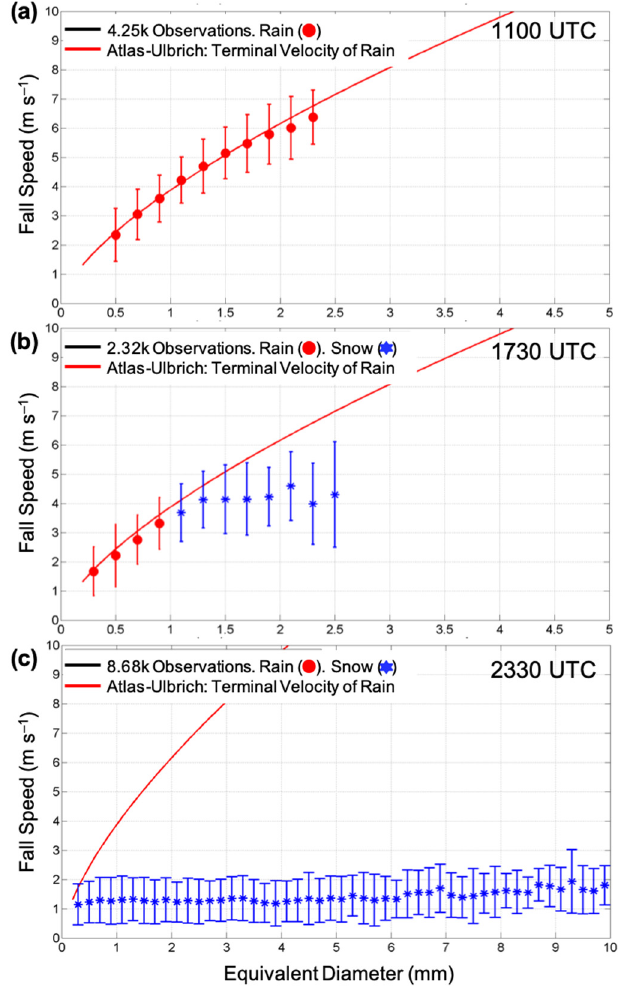
Figure 1. PIP observations of mean fall speed as a function of D e for the example transition event on 24 October 2017. At 1100 UTC ( a ) all the precipitation is classified as rain (red circles) and particle fall speed is along the theorized terminal velocity of rain [42]. At 1730 UTC ( b ) a mixture of rain and snow exists (blue stars), as the larger particles have slower mean fall speeds (and depart from the theorized terminal velocity [42]). Finally, at 2330 UTC ( c ) only snow is present, as the mean fall speeds are much slower that the Atlas–Ulbrich terminal velocity for all D e .